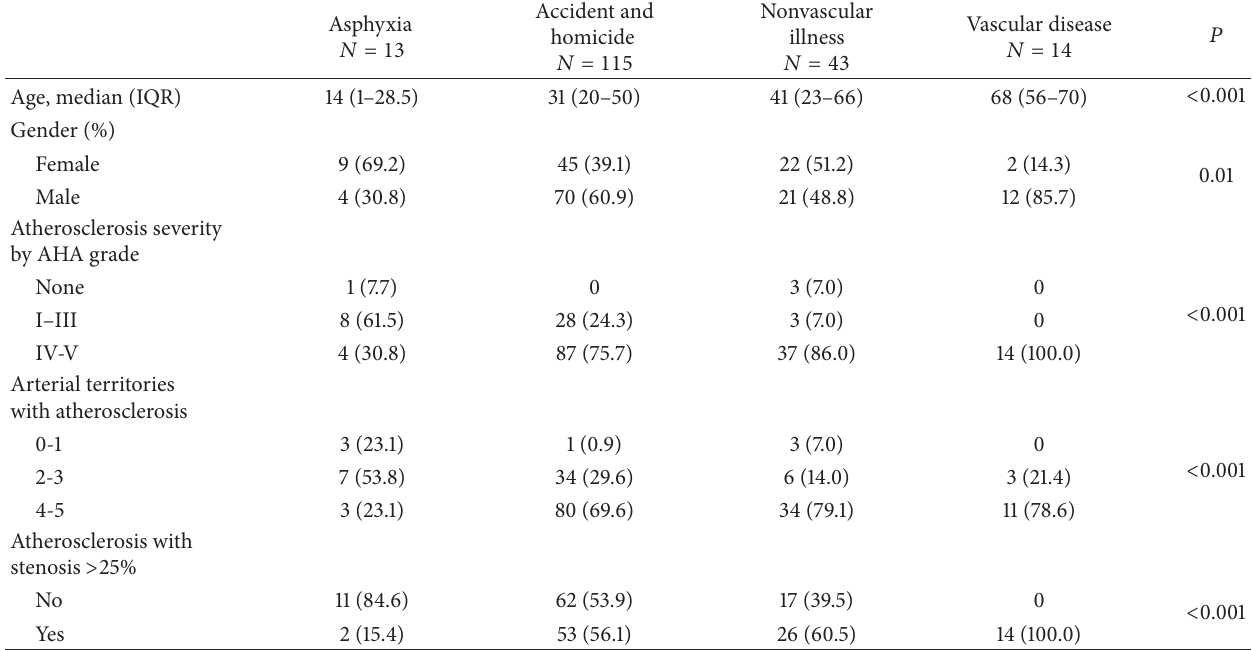
Table 3: Demographic data and atherosclerosis severity according to causes of death.